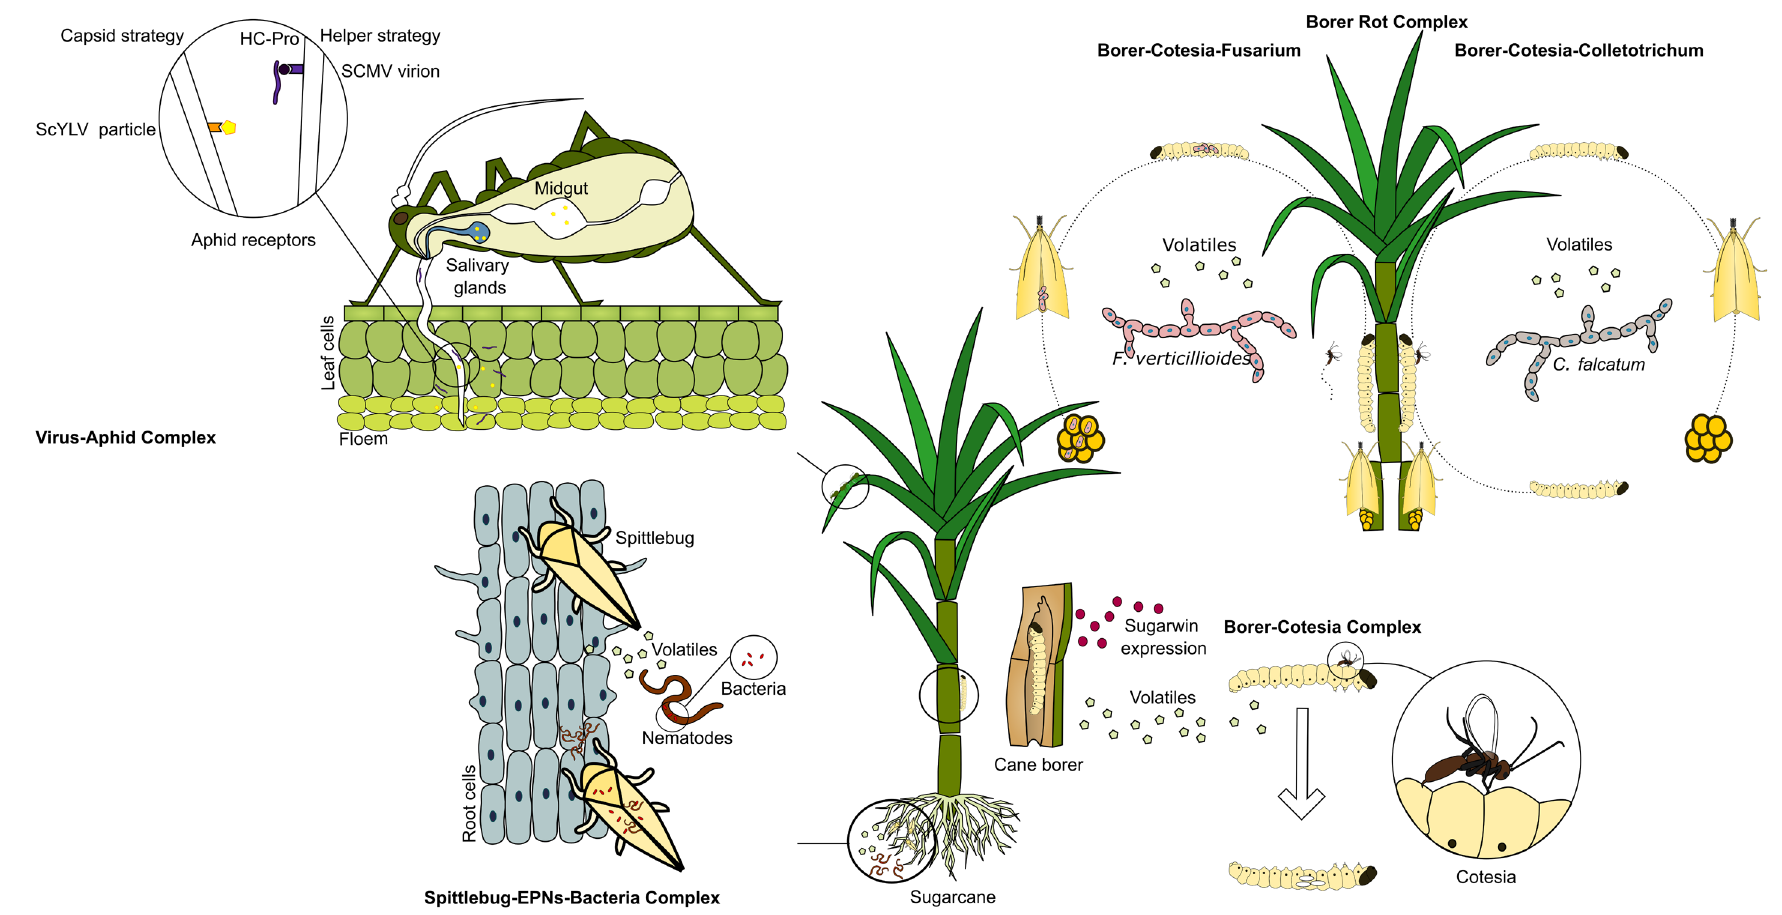
Figure 1 – Multitrophic interactions in sugarcane. In the Virus-Aphid Complex, viral pathogens such as sugarcane mosaic virus (SCMV) and yellow leaf virus (ScYLV) are transmitted through different molecular strategies by aphids feeding on sugarcane leaves. The Spittlebug-EPNs-Bacteria Complex act in root tissue damaged by herbivory which release volatiles organic compounds (VOCs) attractive to nematodes bearing entomopathogenic bacteria lethal to the spittlebug, and released after the nematode enters its host. In the Borer-Rot Complex, D . saccharalis stem herbivory increases the expression of Sugarwins , wound-inducible proteins shown to act selectively against fungal pathogens, but not cause any damage to the insect. Rot causing pathogen Fusarium verticillioides is capable of drastically increase its dissemination by changing VOC profile during infection, manipulating borer and moth behaviors and being transmitted vertically to D . saccharalis offspring. Colletotrichum falcatum also takes advantage of VOC profile alteration during infection and increase its dissemination, as vectors present increased preference to infected plants. The Borer-Cotesia Complex is widely explored in biocontrol strategies as C . flavipes is involved with parasitism of D . saccharalis borers, and is attracted by VOCs from insect herbivory and feces. In addition, the VOC profile change caused by the presence of F . verticillioides decreases C . flavipes attraction to the plant and, consequently, to its